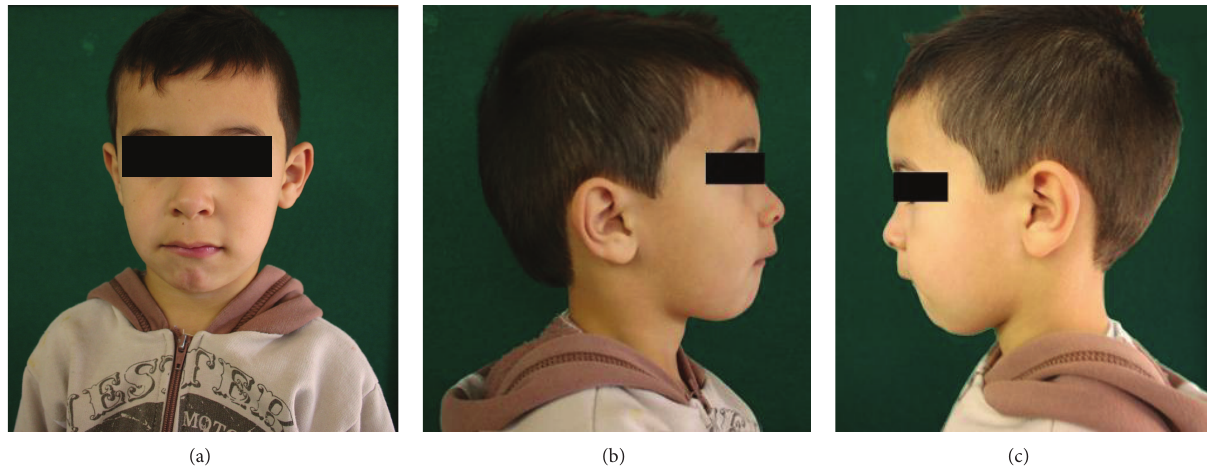
Figure 1: (a) Frontal facial view of a 5-year-old child patient; (b) right lateral facial view; (c) left lateral facial view. Note that patient presented lower lip interposition.